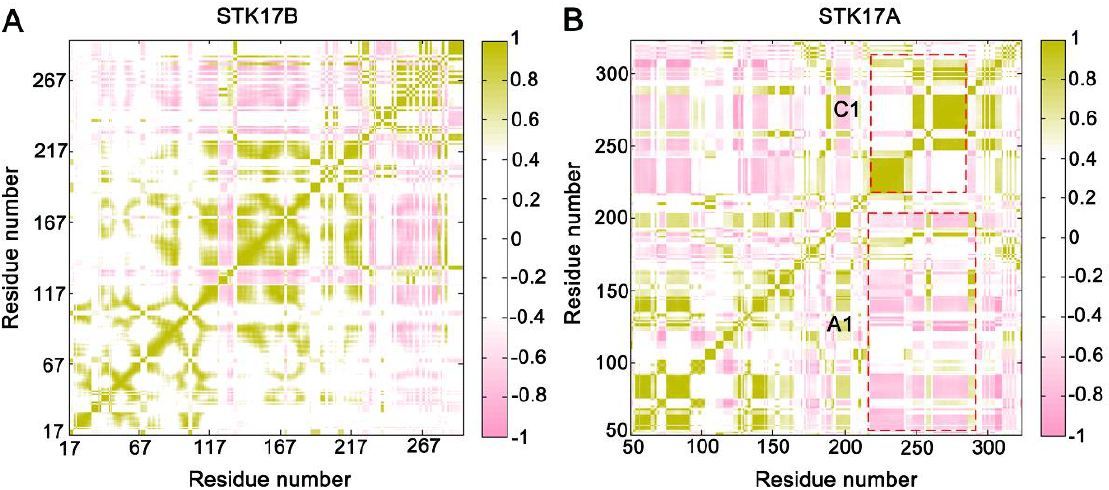
Figure 5. The dynamical cross-correlation matrix (DCCM) of the STK17B ( A ) and STK17A ( B ) systems. Correlated motions with absolute values < 0.4 are ignored for clarity and shown in white. A1 shows anti-correlated motions between the A-loop and the N-terminus, and C1 represents the correlated motions between the A-loop and the C-terminus.